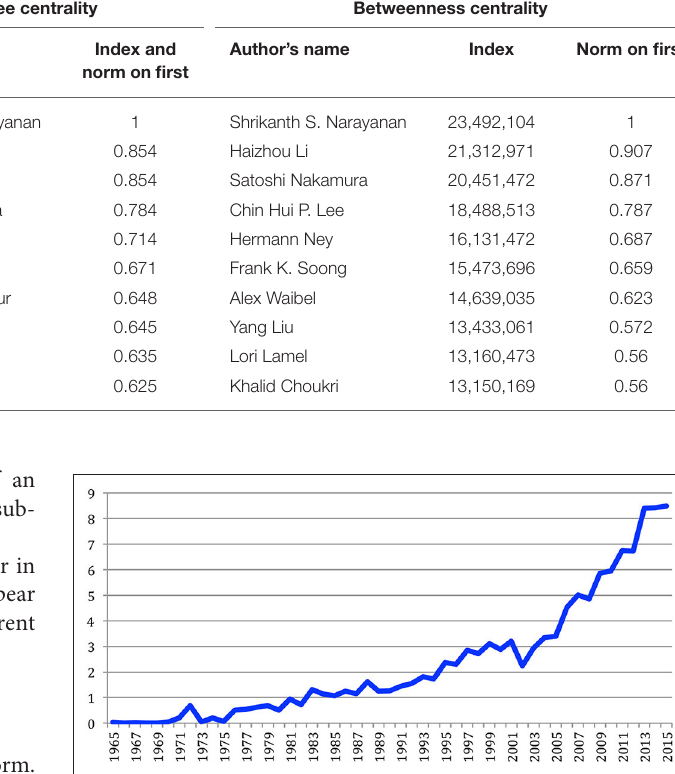
TABLE 8 | Computation and comparison of the closeness centrality, degree centrality and betweenness centrality for the 10 most central authors. Closeness centrality Degree centrality Betweenness centrality